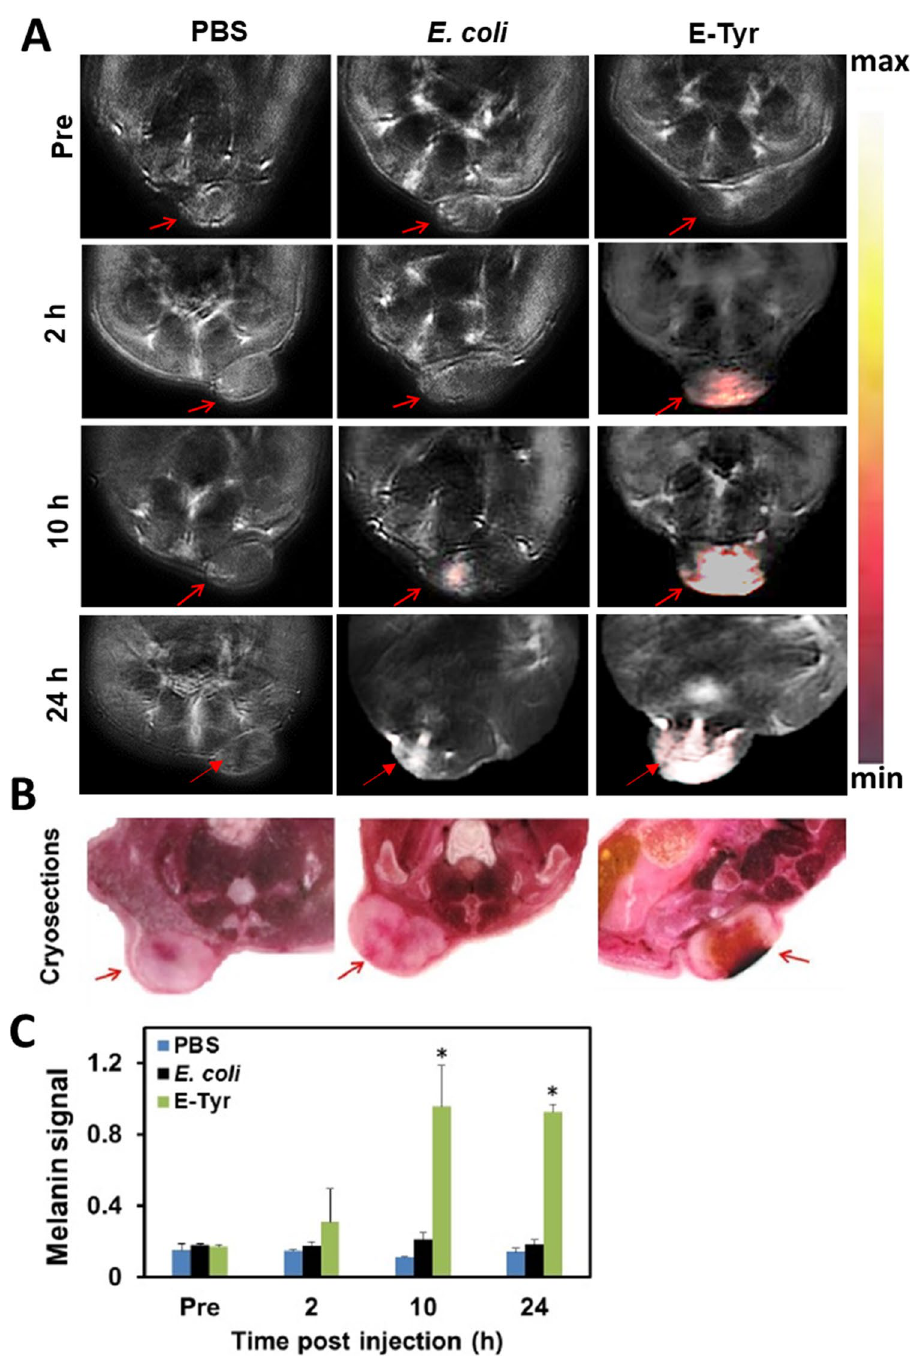
Figure 2. MSOT imaging of CT26 tumors in mice after injection with E-Tyr. ( A ) MSOT images of melanin signal in CT26 tumor bearing live mice (n = 6/group) with the indicated time after E-Tyr (1 × 10 8 cfu) injection. Unmixed melanin overlaid on anatomy. The tumor area is indicated by a red arrow (left; PBS injected control mice, middle; E. coli injected mice, right; E-Tyr injected mice) ( B ) Cryo-slice images of ( A ) indicated tumor by red arrow after MSOT imaging. ( C ) Quantitative optoacoustic signal for melanin of tumors at indicated times for PBS, E. coli and E-Tyr injected mice. (* P <